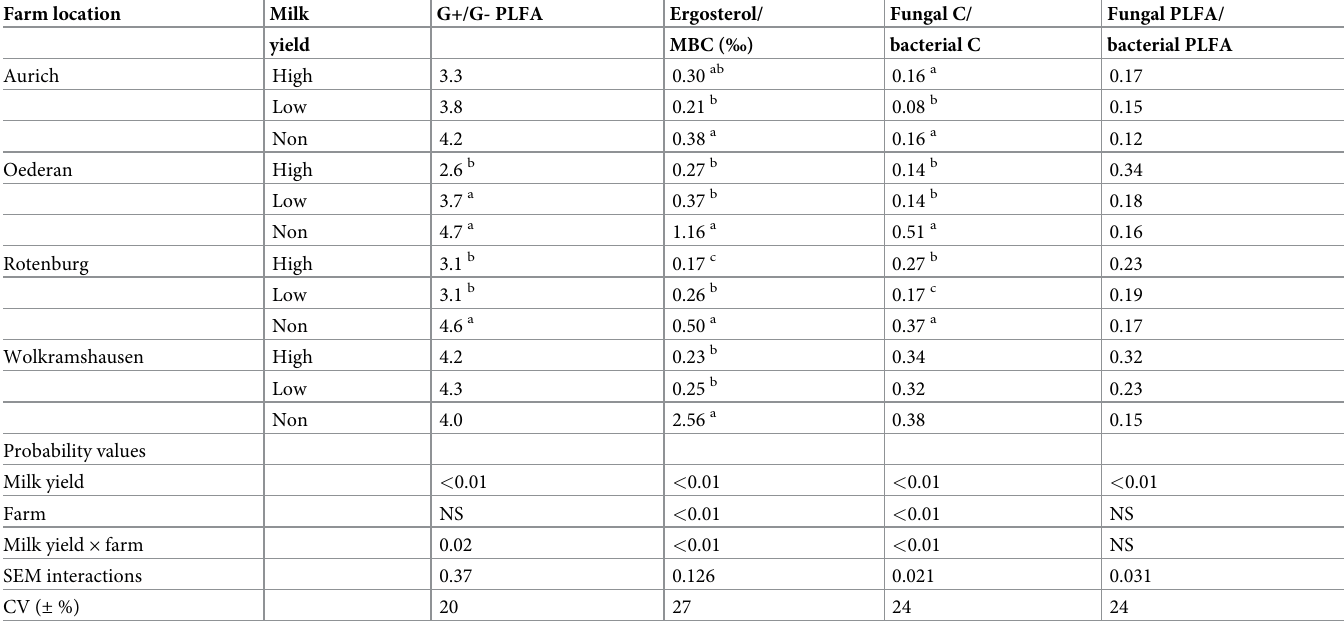
Table 5. Mean ratios of Gram-positive/Gram-negative phospholipid fatty acids (G+/G- PLFA), ergosterol/microbial biomass C (MBC), fungal C/bacterial C, and fungal PLFA/bacterial PLFA in the cow faeces, broken down according to the four farms and the three milk yield groups. Farm